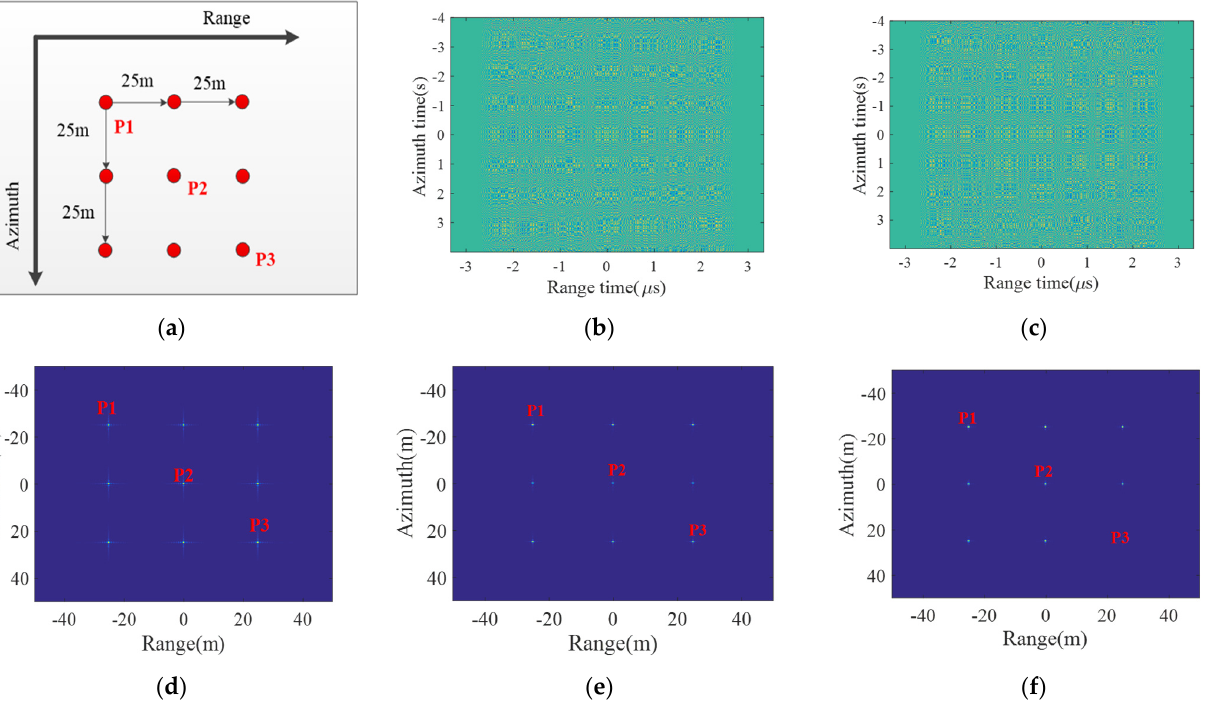
Figure 9. Imaging results of the designed scene with nine point targets. ( a ) The designed scene with nine point targets. ( b ) Real part of echoes in the conventional starring spotlight mode. ( c ) Real part of echoes in the proposed starring spotlight mode. ( d ) Focused image in the conventional mode. ( e ) Focused image with window weighting in the conventional mode. ( f ) Focused image in the proposed mode.